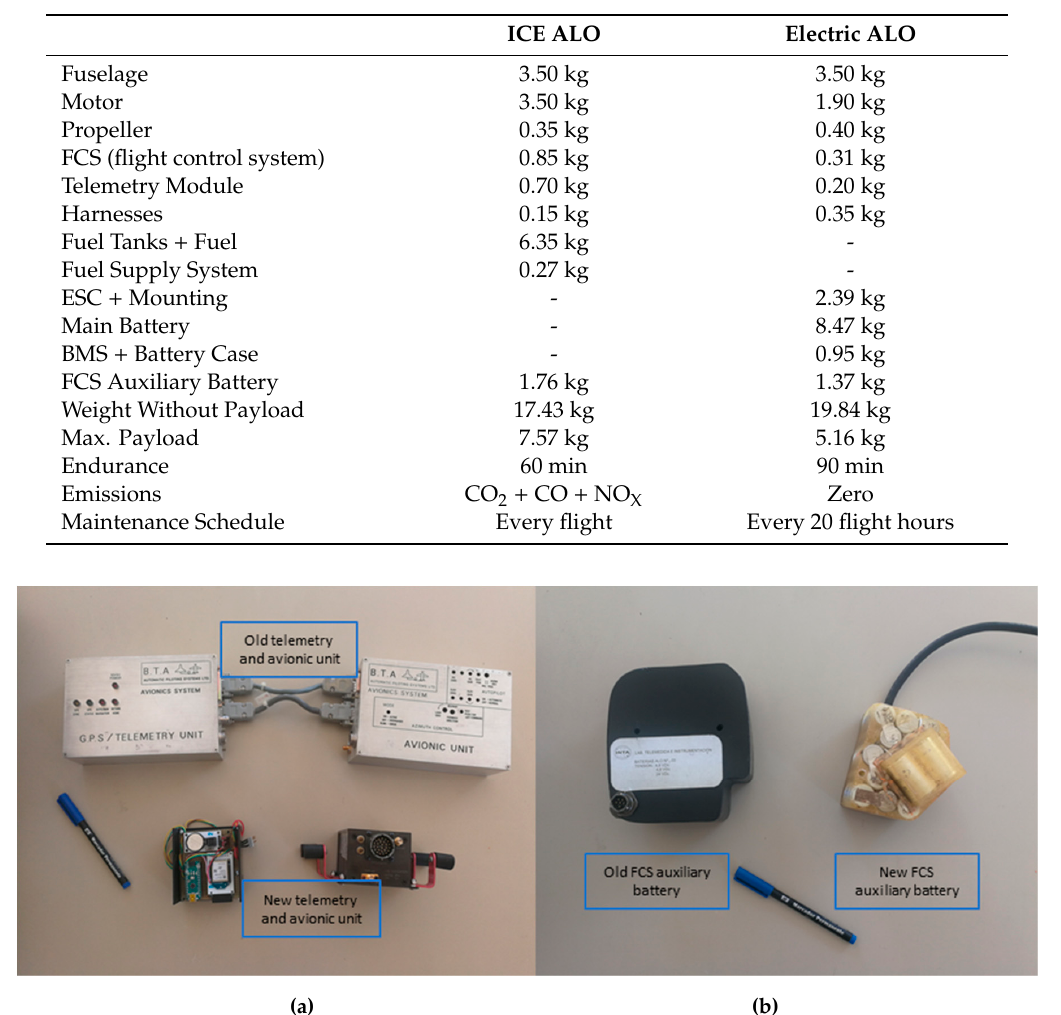
Table 11. ICE ALO vs. electric ALO main features.